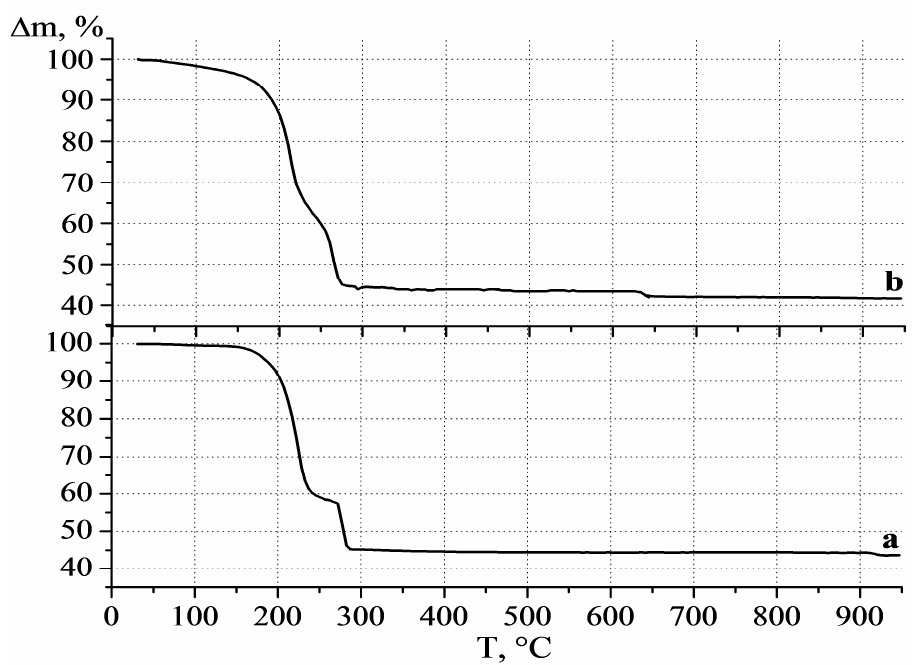
Figure 5. TG curves of a mixture of FeC 2 O 4 ·2H 2 O and CoC 2 O 4 ·2H 2 O without preliminary treatment ( a ) and after mechanical activation for 45 min ( b ).